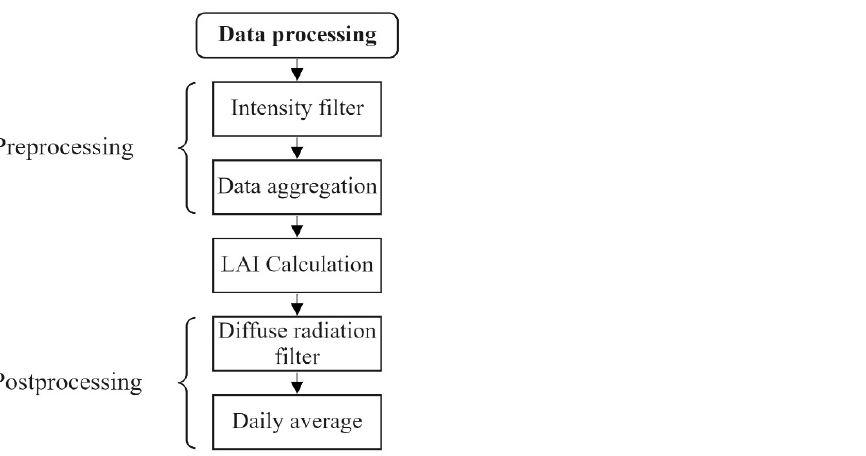
the field experiment. the field